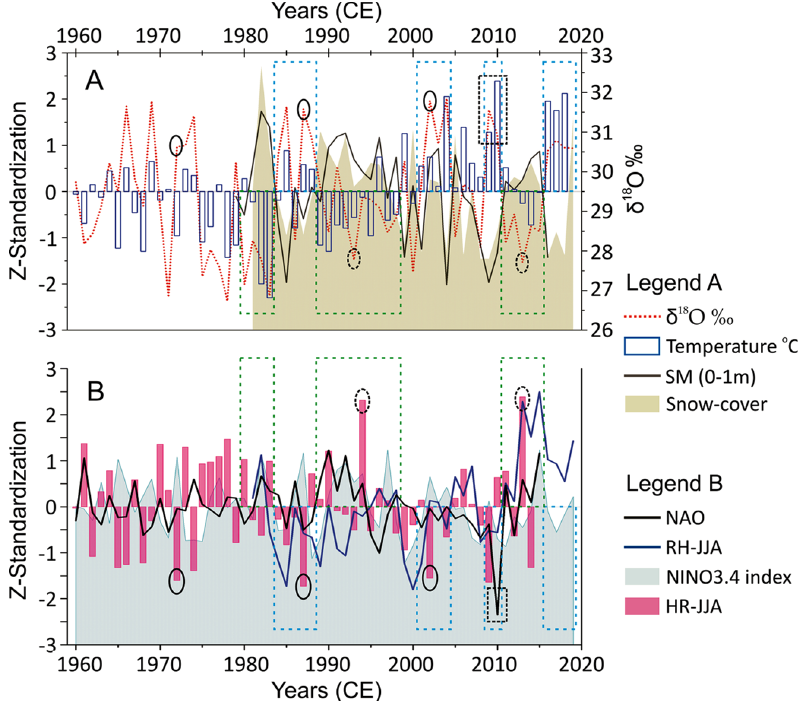
Figure 6. Overview of the Z ‐ Standardised (1960–2019 CE) new δ 18 O TRC series. Green (blue) dashed boxes represent low (high) mean δ 18 O TRC values indicating wet (dry) phases corresponding with low (high) temperatures, high (low) snowcover, soil moisture in ( A ) and relative humidity in ( B ) for spring months, and with high (low) rainfall for summer (JJA) months (in B). Black dashed ovals ( A , B ) show the highest rainfall years corresponding to low temperature and low δ 18 O TRC . Solid black ovals show correspondence between years having low rainfall (HR) and high δ 18 O TRC . Dashed black box ( B ) indicates the highest negative NAO year, coinciding with low snow cover, high temperature, and high δ 18 O TRC.